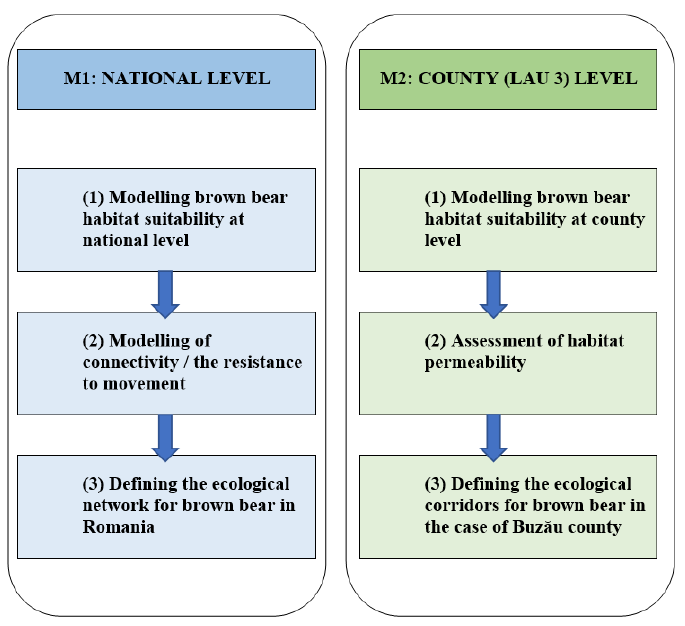
Figure 2. Methodology for identifying ecological networks and corridors for the brown bear species.